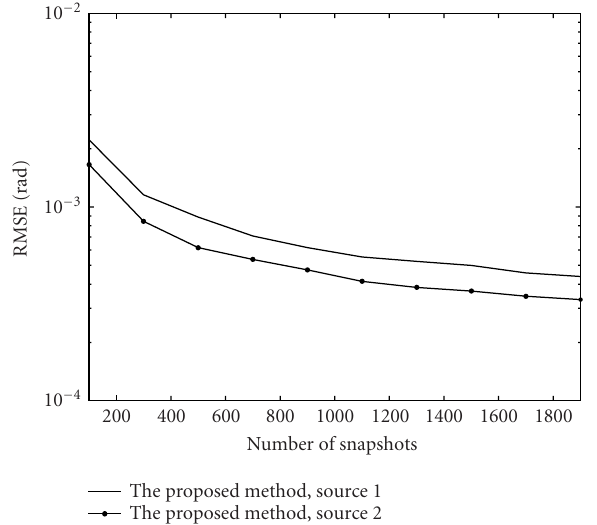
Figure 7: The RMSE of the estimated frequency over 500 Monte Carlo runs versus the number of snapshots; 14 sensors are used and the SNR is fixed at 15dB. Two equi-power sources approach the ar- ray from 38 ◦ and 20 ◦ ,